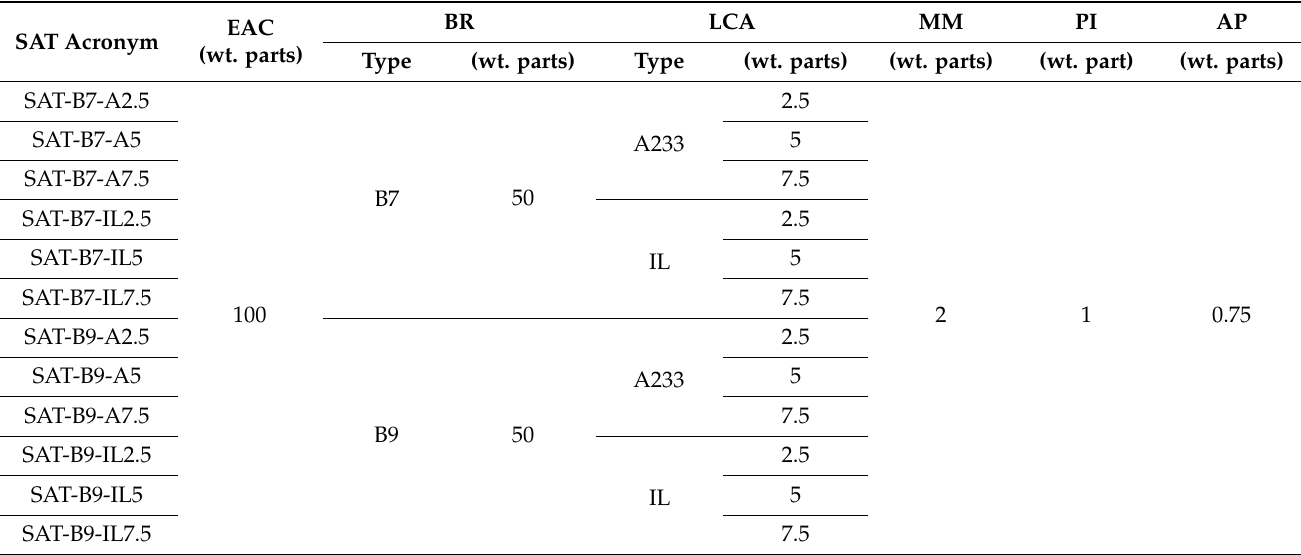
Table 3. Structural self-adhesive tape compositions containing different benzoxazine resins and latent curing